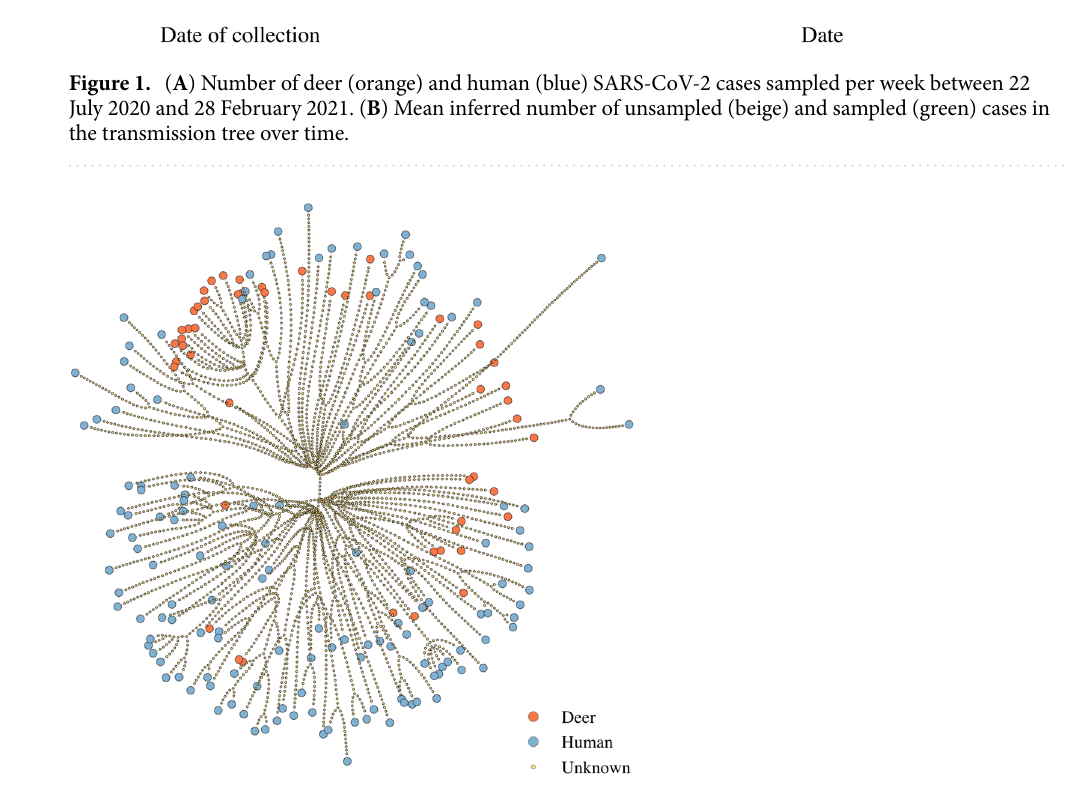
Figure 2. Medoid inferred transmission network for SARS-CoV-2 cases in white-tailed deer (orange) and humans (blue) in Iowa between July 2020 and February 2021. Nodes represent cases and edges represent transmission events. Unsampled cases are shown as smaller nodes and correspond to inferred transmission